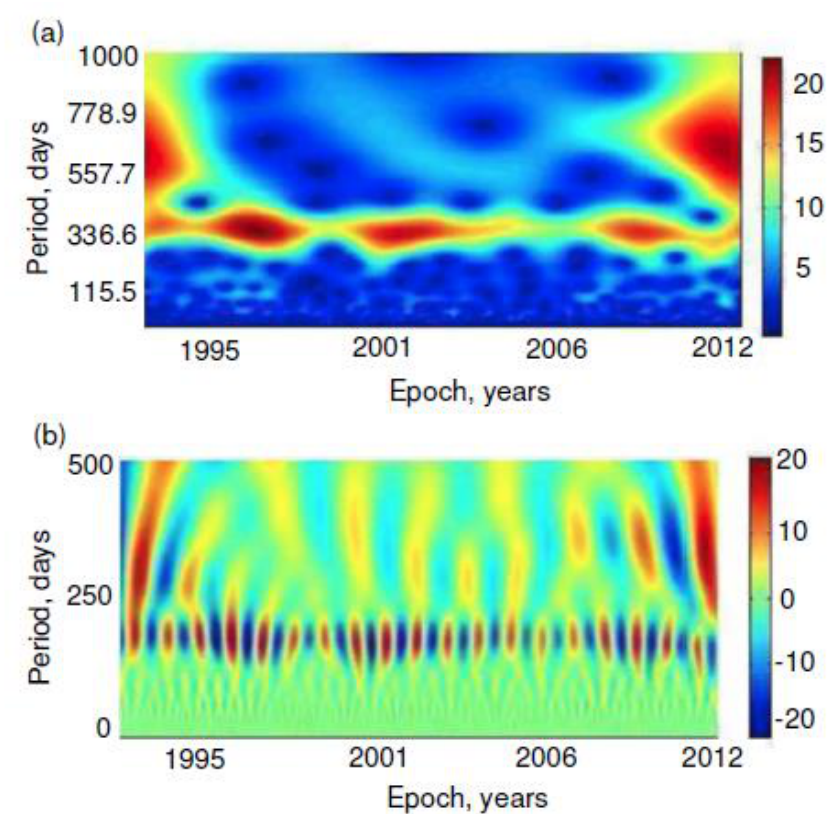
Fig. 1. Continuous frequency - time wavelet analysis ( wavelets ' morl ') of data on corrections to verti- cal deformations of the earth’s surface at Katsively point: a - "Atmosphere" model; b - “Ocean” model.